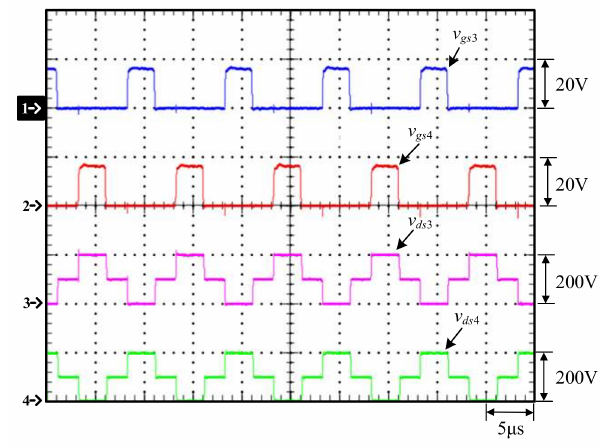
Figure 16. Measured waveforms relevant to rated load: (1) v gs 3 ; (2) v gs 4 ; (3) v ds 3 ; (4) v ds 4 .